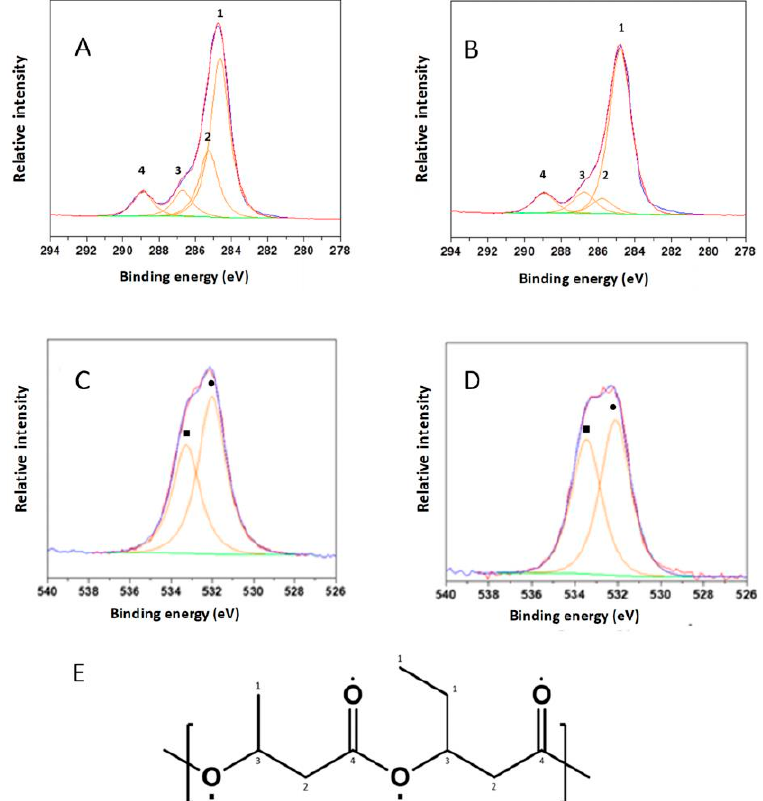
Figure 6. XPS spectral analysis on the surface of PHBV films. C1s spectra: ( A ), ENMAT and ( B ), PHBV from fermented R-NF; O1s spectra: ( C ), ENMAT and ( D ) from fermented R-NF. Peaks numbers and symbols correspond to functional groups reported in the structure of the PHBV polymer represented in panel ( E ). Relative abundances are detailed in Table 6. Table 6. Spectral components and relative abundance (%) of the surface of PHBV film purified from R-NF fermented with Hfx. mediterranei DSM1411 (EXP) and of the commercial reference ENMAT™ Y1000P, as obtained by XPS analysis. Peak *